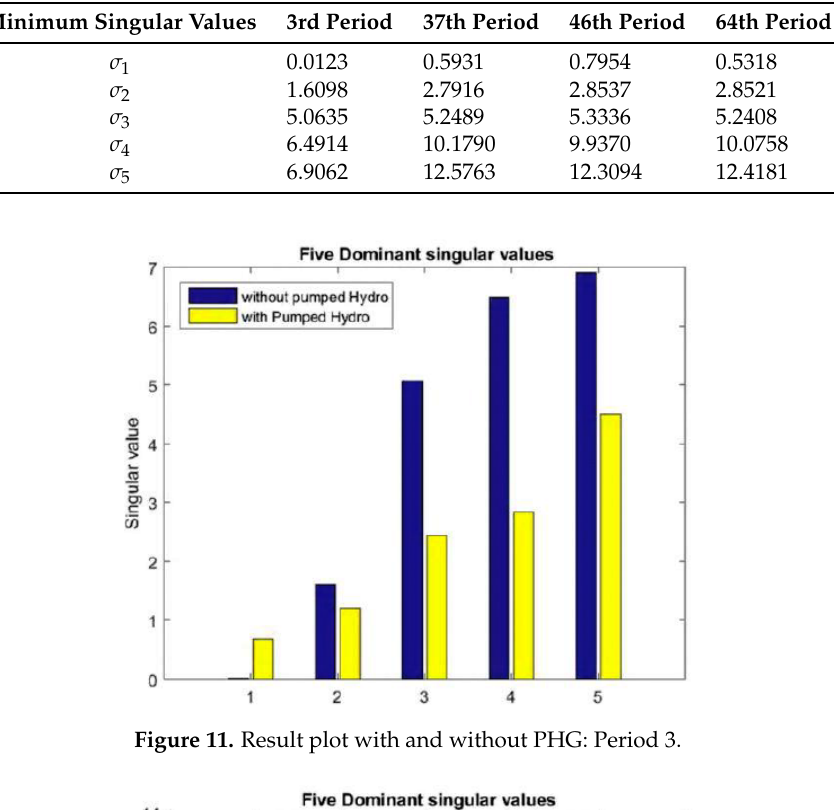
Table 5. First 5 minimum singular values (MSVs) for all four periods of wind curtailment on the 3rd, 37th, 46th, and 64th periods: Case III.